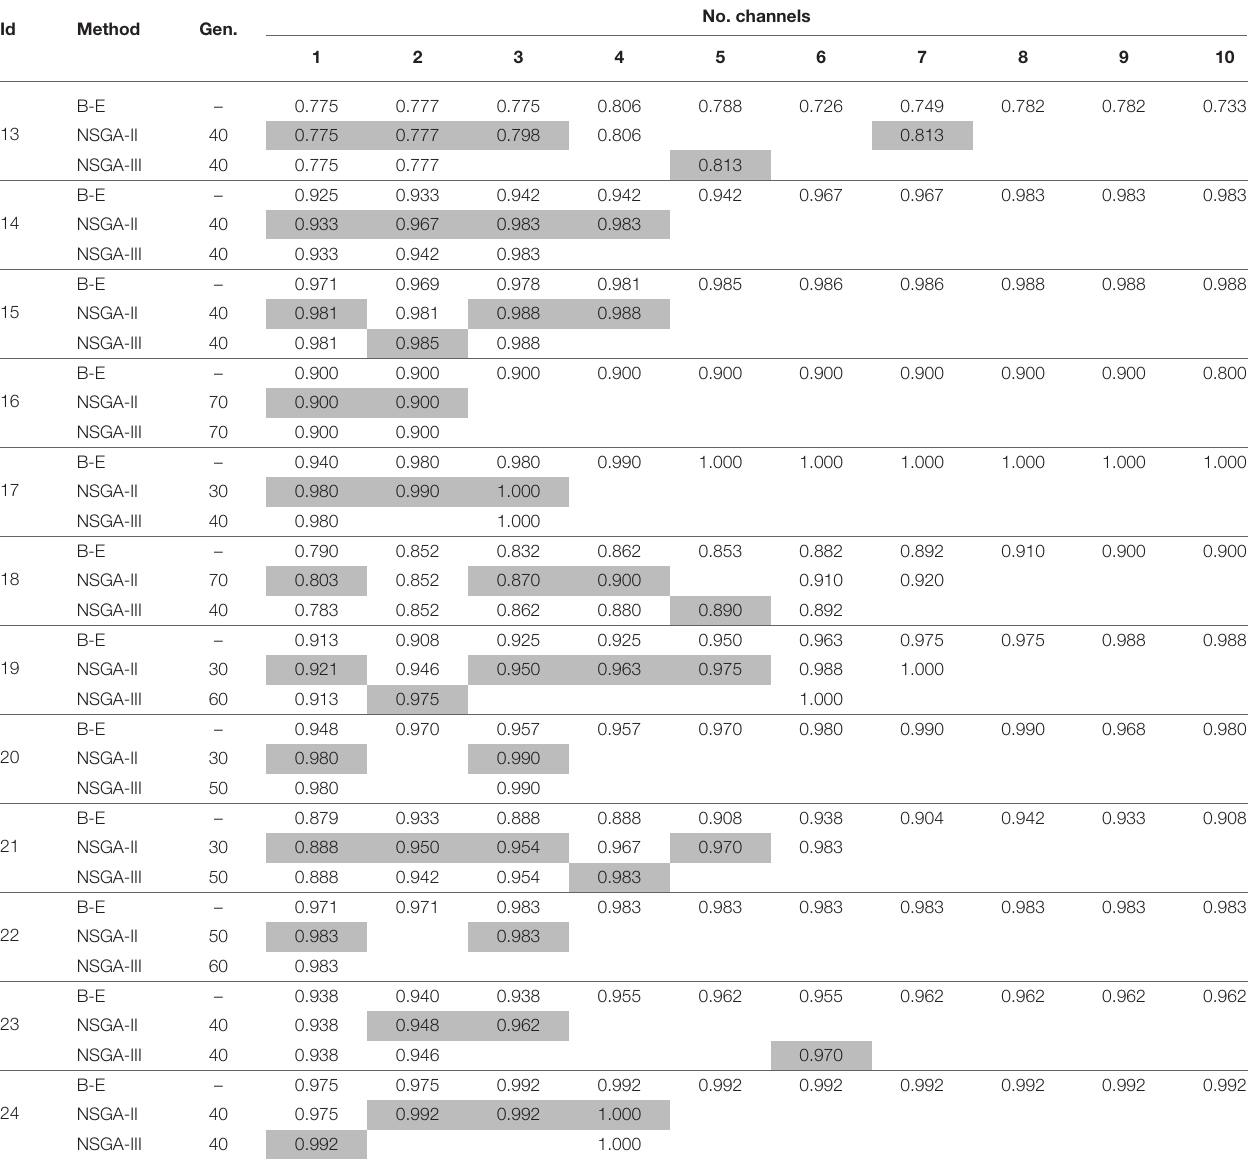
TABLE 2 | Accuracies obtained using EMD for feature extraction with NSGA-II and NSGA-III for EEG channel selection (Subjects 13–24).